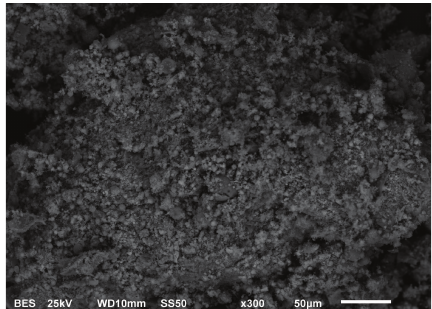
Figure 3: SEM image of untreated sample FA-UW.